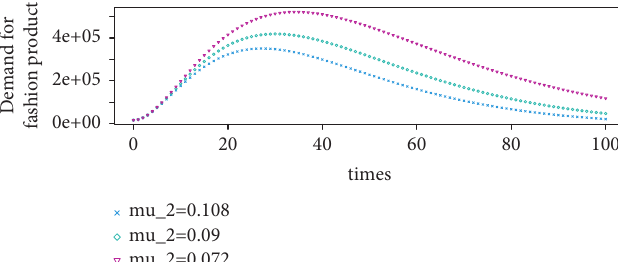
Figure 12: Simulation of demand for fashion products at different rates of recovery μ increases, while the demand for fashion products shifts inward, indicating a decline in COVID-19 μ 2